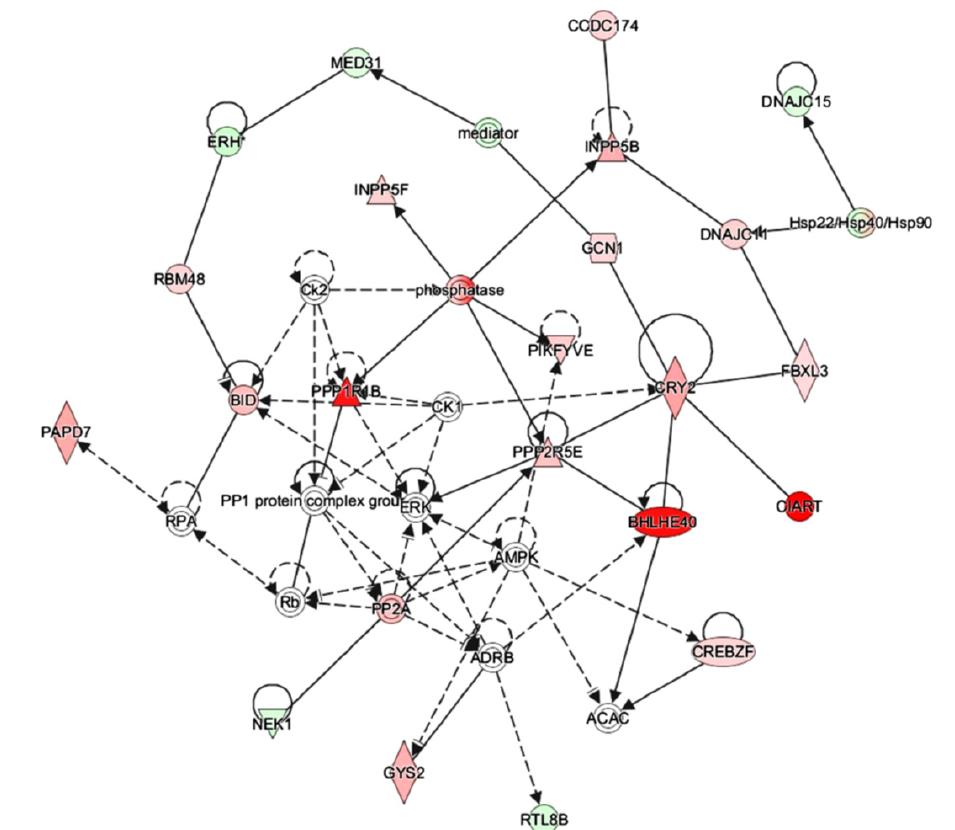
Figure 8. Gene network of octacosanol regulating the lipid metabolism. The normalized gene chip data were uploaded into IPA software to produce the gene network through an automatic comparison between our data with the IPA database. Red, increased expression genes; green, decreased expression genes; and the darkness of the color stands for the ratio of fold change. Gene network of octacosanol regulating the lipid metabolism.